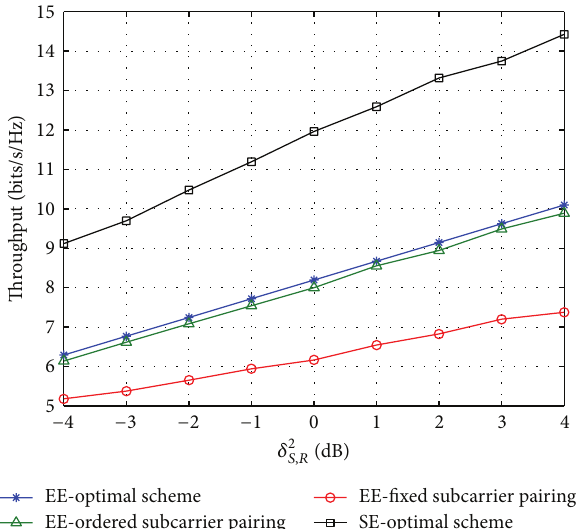
Figure 7: Throughput versus channel variance of 𝑆 → 𝑅 link with = 𝑤 = 1 . 𝑁 = 12 relays, and 𝑤 1 2